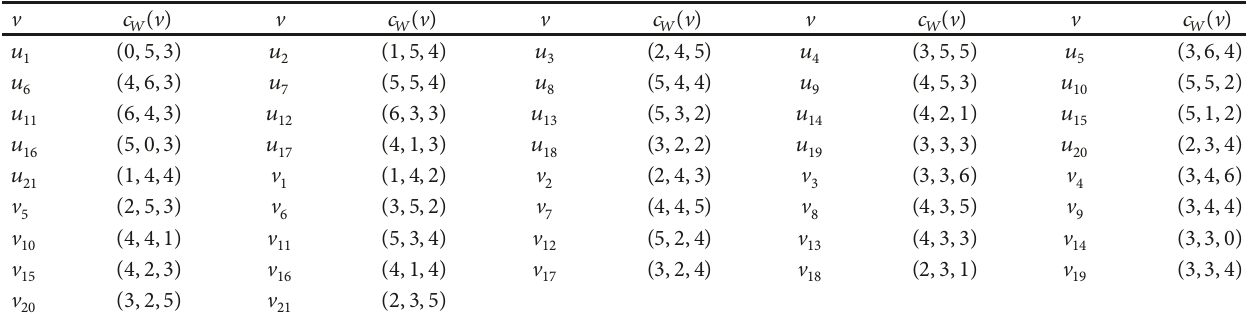
Table 10: The code 𝑐 𝑊 ( V ) of V with respect to 𝑊 = {𝑢 1 ,𝑢 16 , V 14 } in 𝑃(21,4) .